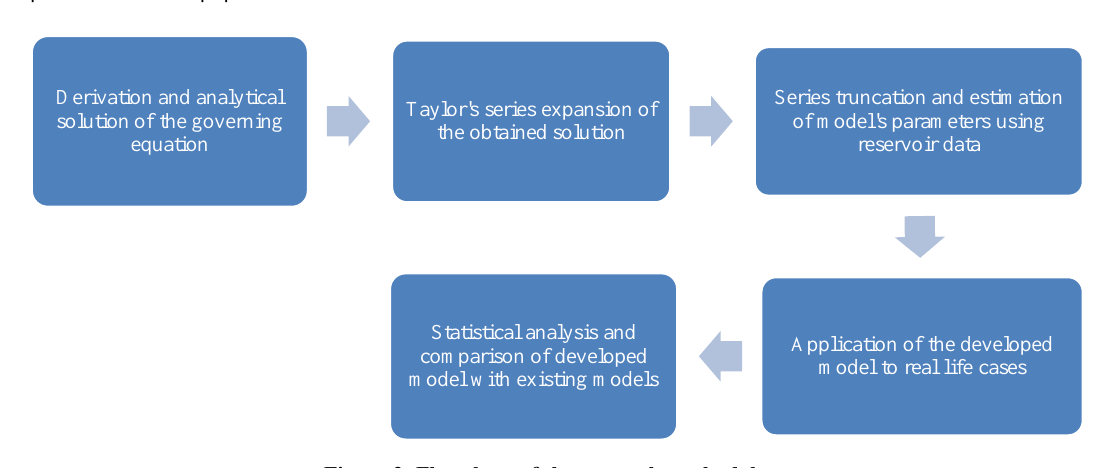
Figure 2. Flowchart of the research methodology